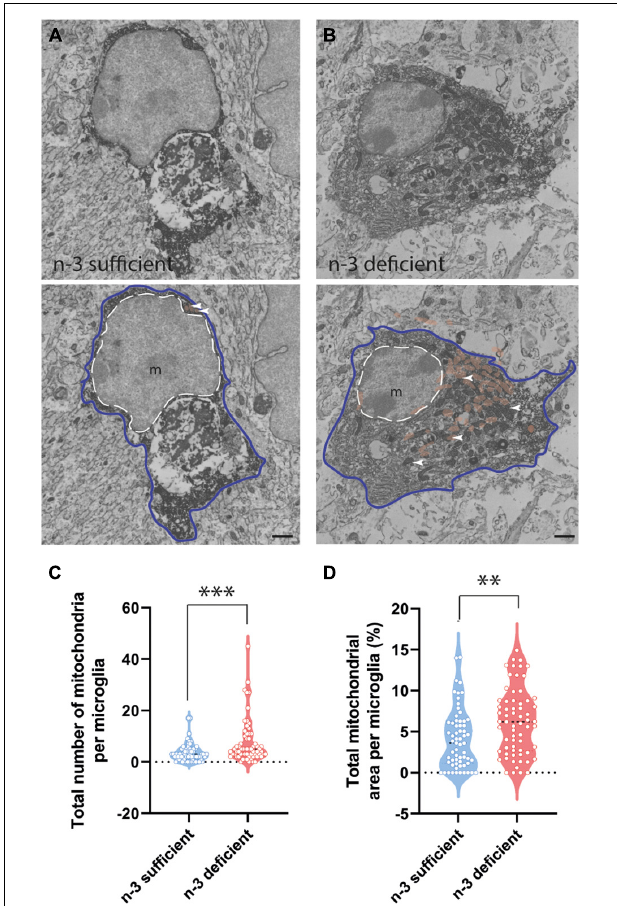
FIGURE 3 | N-3 PUFA deficiency increases mitochondrial abundance and area in microglia at P10. (A,B) Representative images of microglial ultrastructure in the corpus callosum of P10 mice, showing the abundance of mitochondria (upper panels: original images, lower panels: with false colors: e.g., mitochondria in orange + white arrowheads) (magnification: 10,000 × ) (scale bar = 1 µ m) in n-3 sufficient mice (A) and n-3 deficient mice (B) . Microglia are annotated with “m,” the contour of their nucleus is delineated with a white dotted line and the cytoplasm by a purple line. Mitochondria are highlighted in false color (light brown). (C) Quantification of number of mitochondria in microglia cells from both dietary groups. (D) The percent of cytoplasm containing mitochondria in both dietary groups. All data are presented as mean ± SEM. n = 63–65 microglia/group, N = 6 animals/group. ** p < 0.01, *** p <